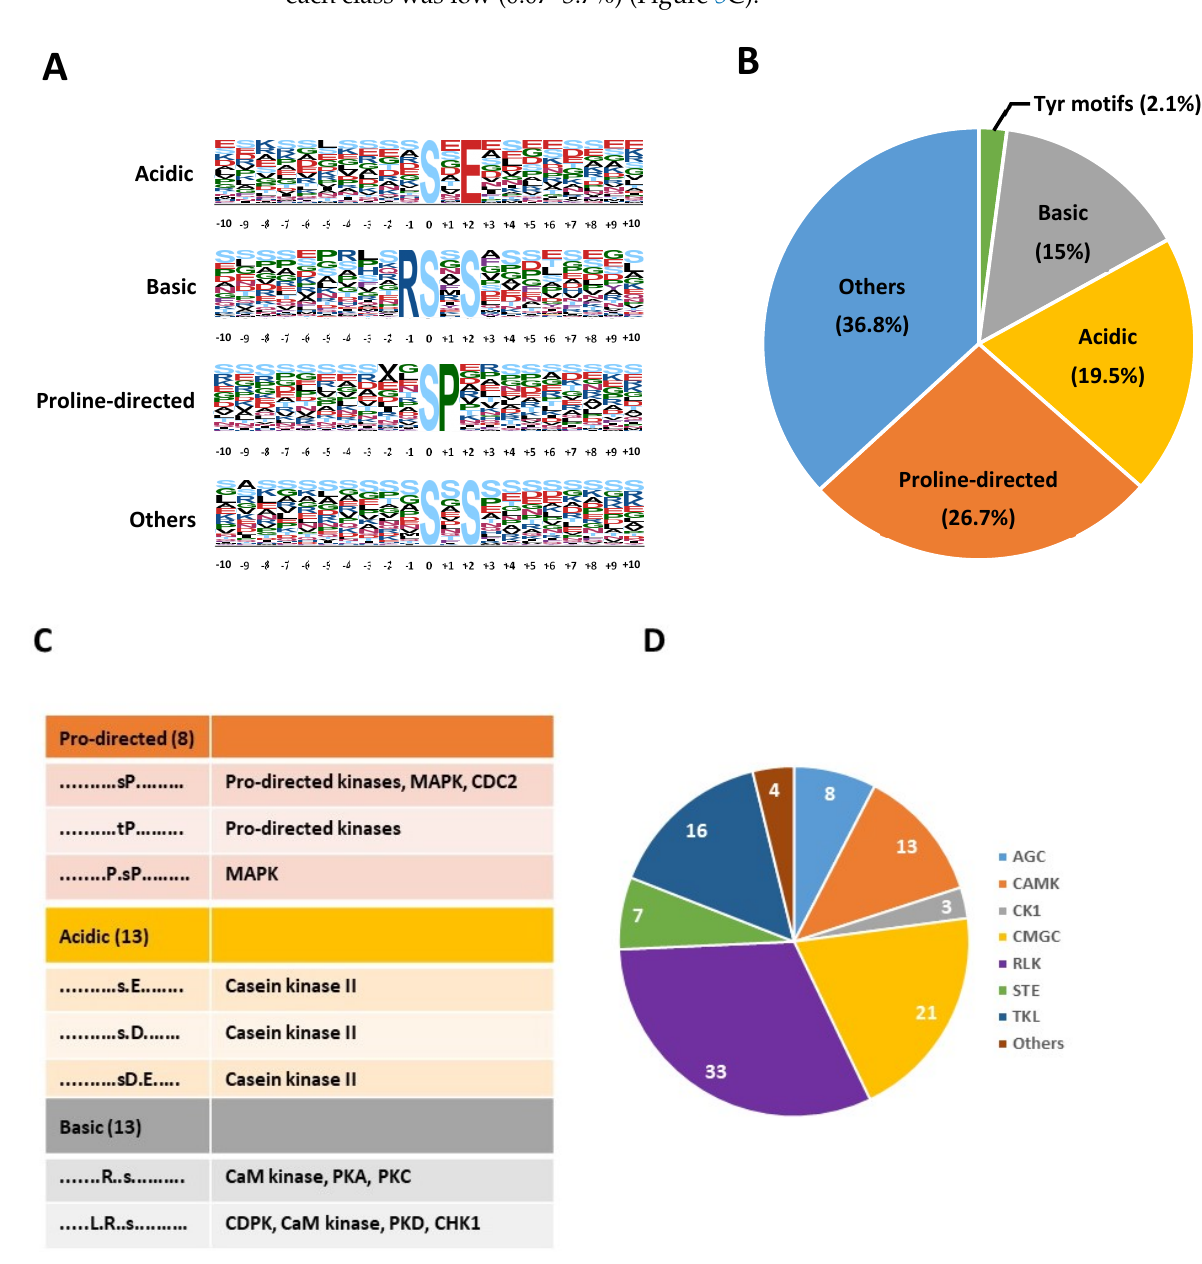
Figure 4. Identification of phosphorylation motifs enriched in seed phosphopeptides. ( A ) Overrepresented motifs identified by Motif-X software in pS/pT peptides. Full information is presented in Table S5. ( B ) Relative abundance of acidic, basic, Pro-directed, Tyr-containing, and other motifs in seed phosphopeptides. ( C ) Protein kinase classes preferentially targeting identified motifs.